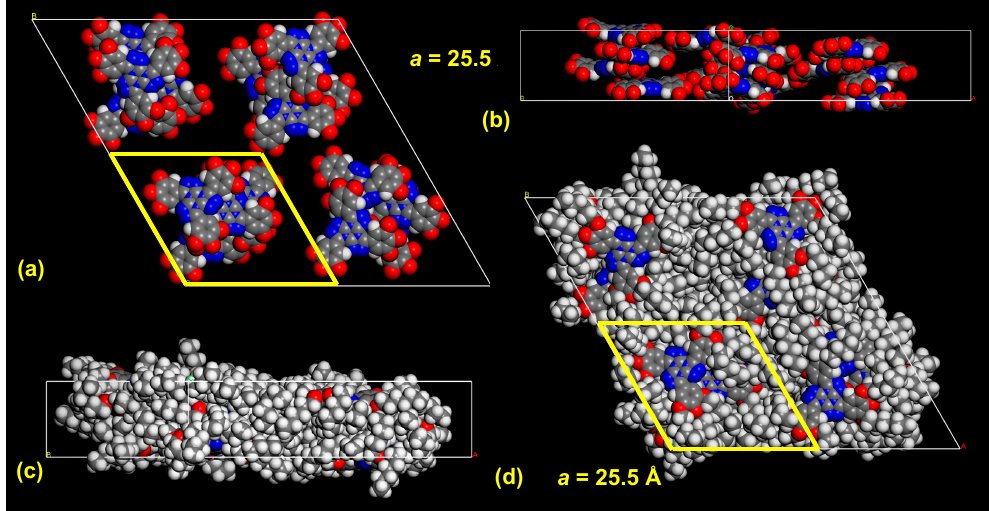
Figure 3. Model of a supercell (2 a × 2 a × 4 c ) of t -33 . ( a , b ) Top and side view, where hexyl chains are omitted; ( c , d ) side and top view, including hexyl chains.